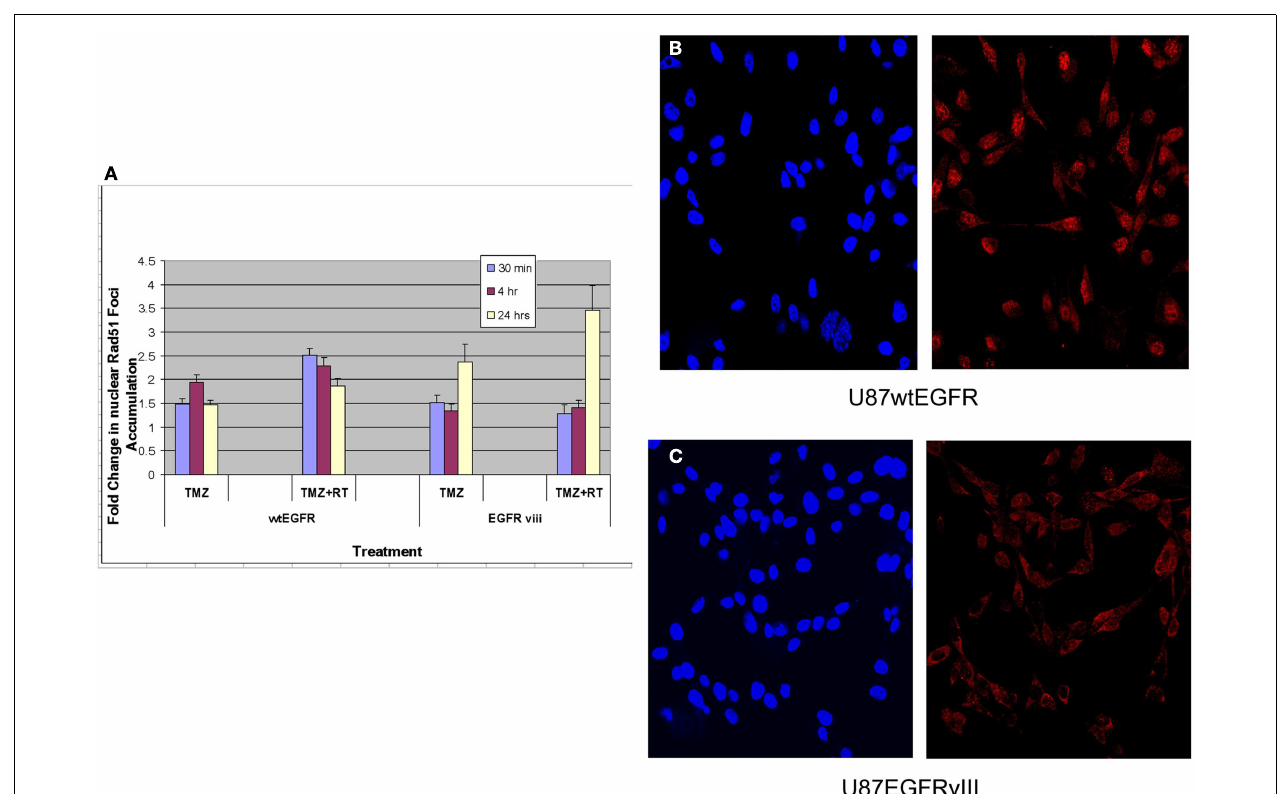
Fold-change in nuclear Rad51 foci relative to control levels following TMZ and/or RT treatment. (B,C) Micrographs showing DAPI staining of nuclei (left panel) and Rad51 staining (right panel) 4h followingTMZ treatment of U87wtEGFR and U87EGFRvIII respectively. Magnification: 400 ×